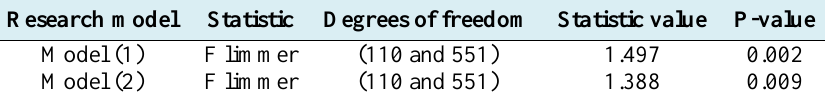
Table 16. The results of the F limmer test in the TSE